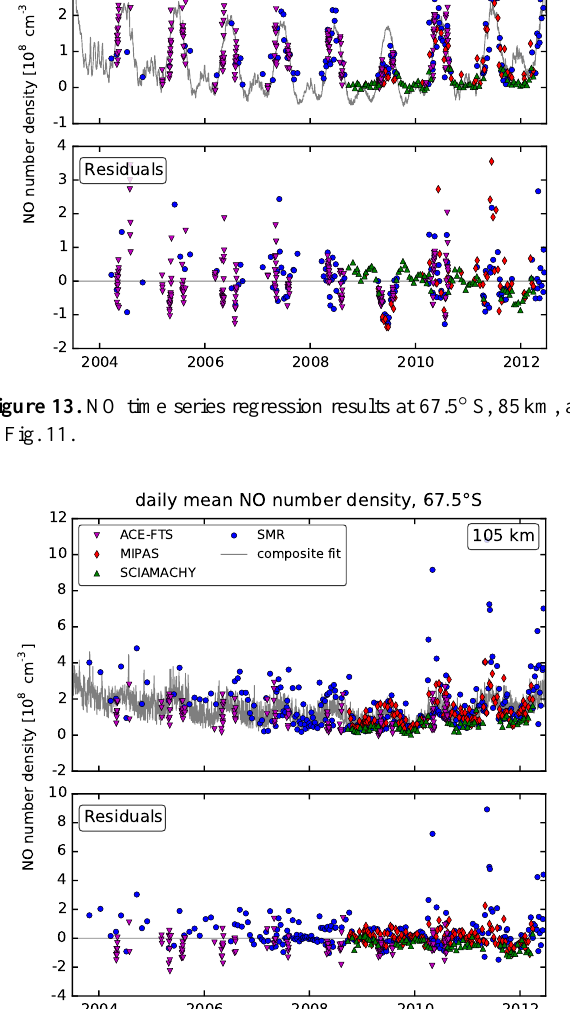
Figure 14. NO time series regression results at 67.5 ◦ S, 105km, as in Fig.